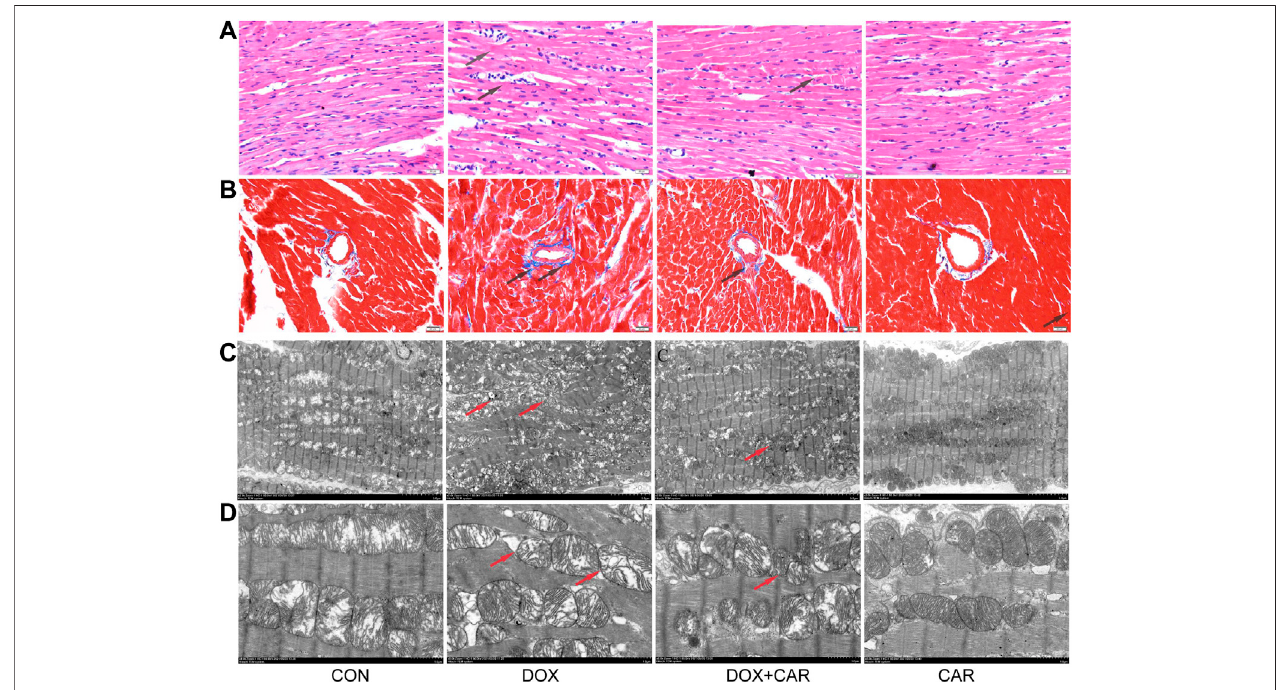
FIGURE2| CARattenuatedthepathologicalalterationsinmyocardialtissuesofDOX-treatedhearts.Representativepicturesofmyocardialtissuesectionsstained withH&EandMasson(magni fi cation=×400) (A) H&Estaining, (B) Masson;n=3,Bar=20 μ m.Representativeimagesofmyocardialtissuesectionstested byTEM (C) , the magni fi cation is 1.5 K times (Scale = 5 μ m). Representative images of myocardial tissue sections tested by TEM (D) , the magni fi cation is 5.0 K times (Scale = 2 μ m).